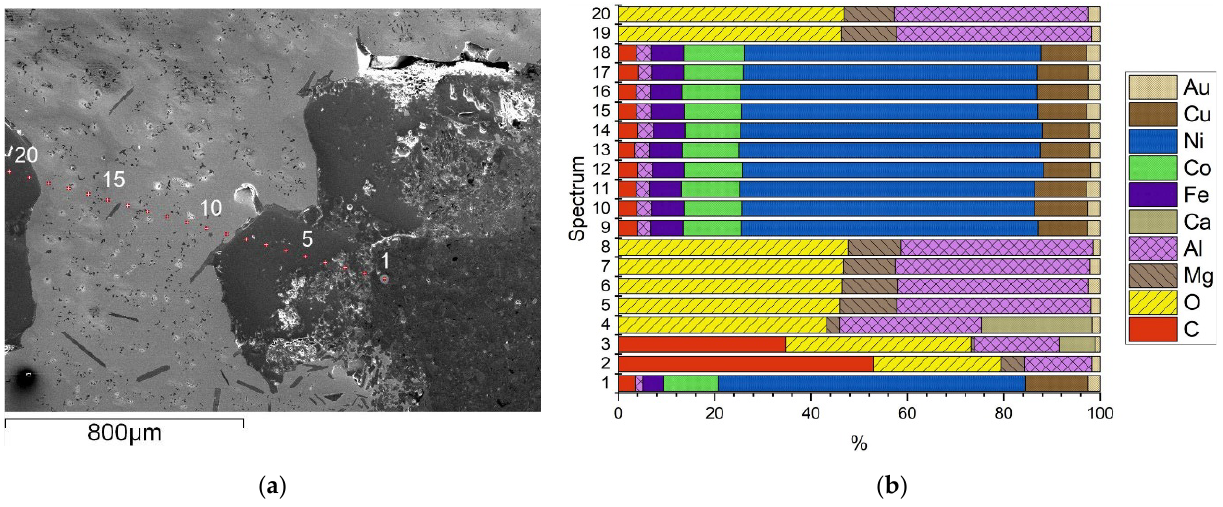
Figure 10. Line spectrum through a metal piece with mineral caking; ( a ) SEM-picture of the particle with the associated analysis point position; ( b ) related composition of each analysis point from (a) using EDX analysis.